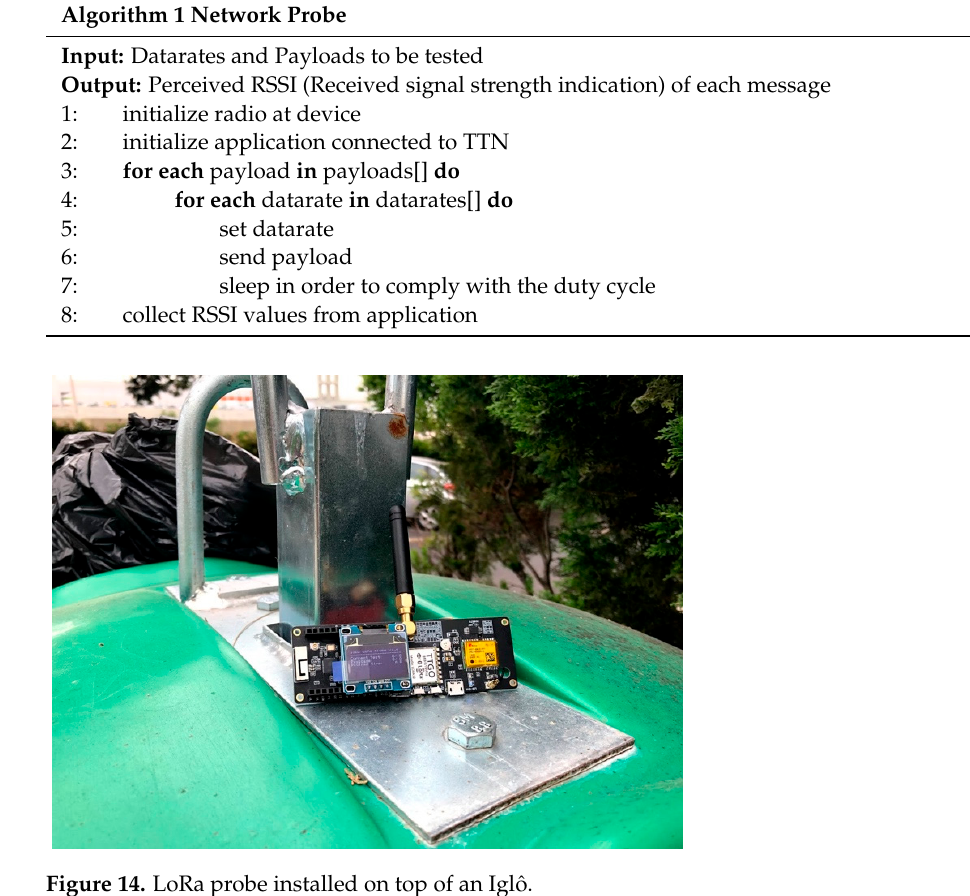
Algorithm 1 Network Probe